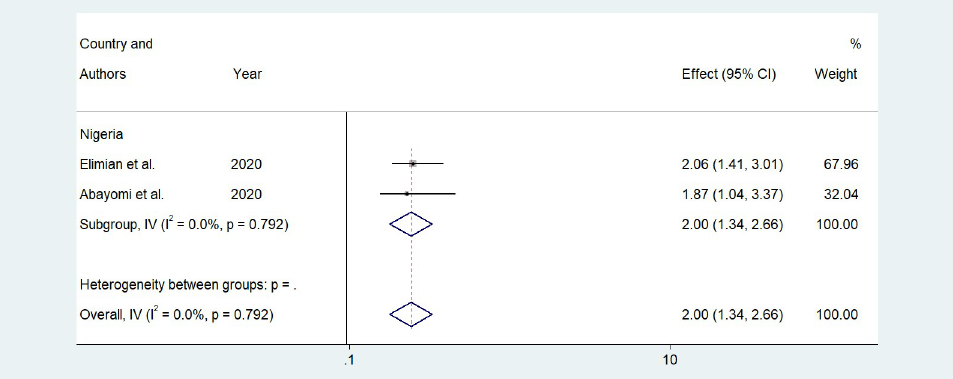
Fig 8. Forest plot showing the estimate for the effects of cough on COVID-19